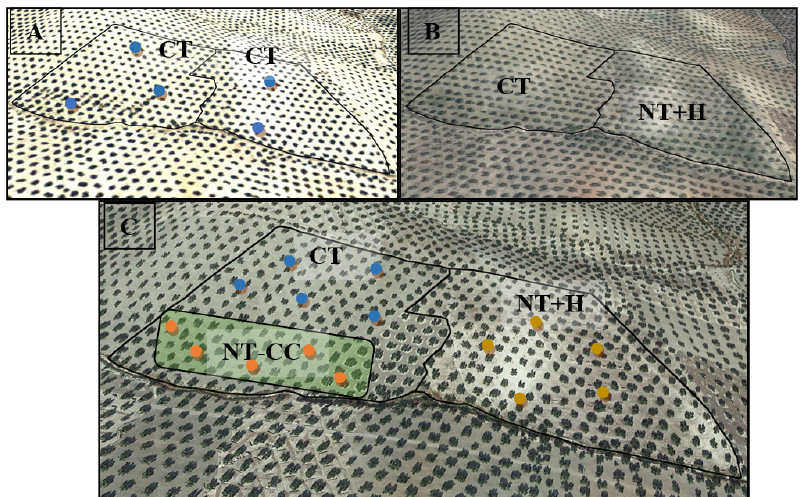
Figure 1. Aerial view of the experimental plots at Torredelcampo (Jaén, Spain). The evolution of the study area and management is marked by different letters: conventional tillage (CT), no tillage (NT + H), and no tillage with cover (NT-CC). ( A ) situation in 2004, ( B ) in 2015, and ( C ) in 2017. Colour (blue, yellow, and orange) circles represent the soil sampling points.